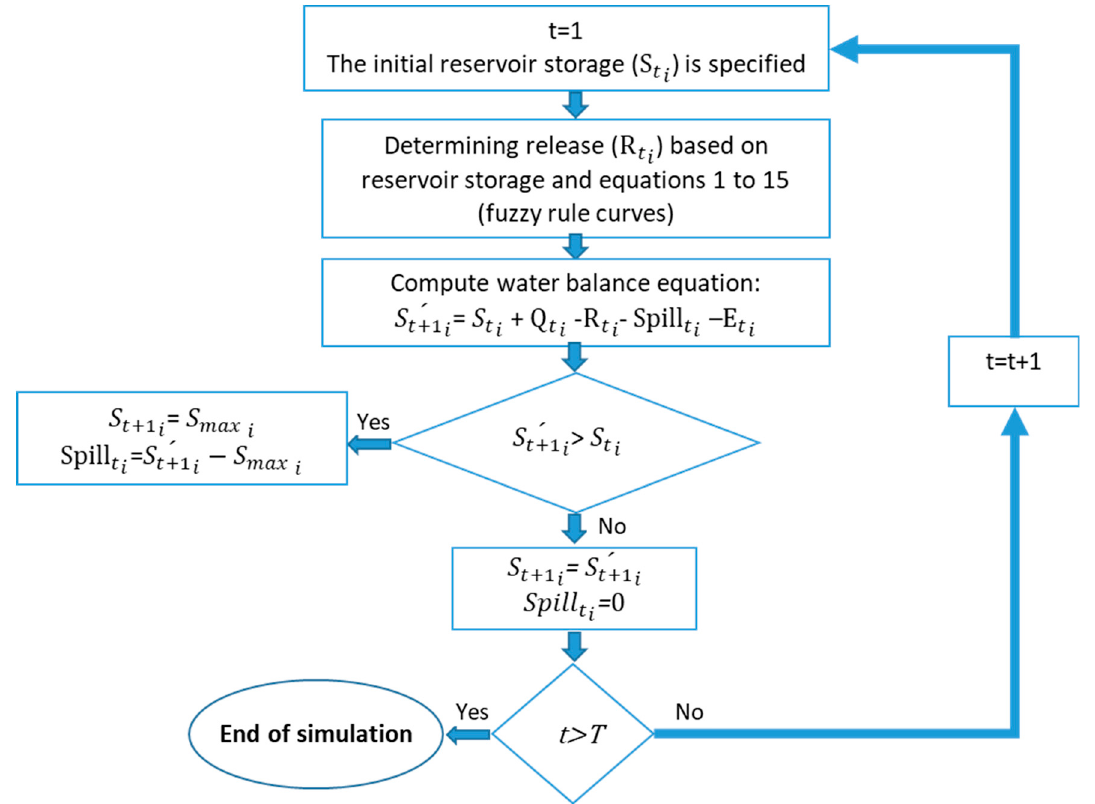
Figure 7. Simulation method for fuzzified discrete hedging rule.